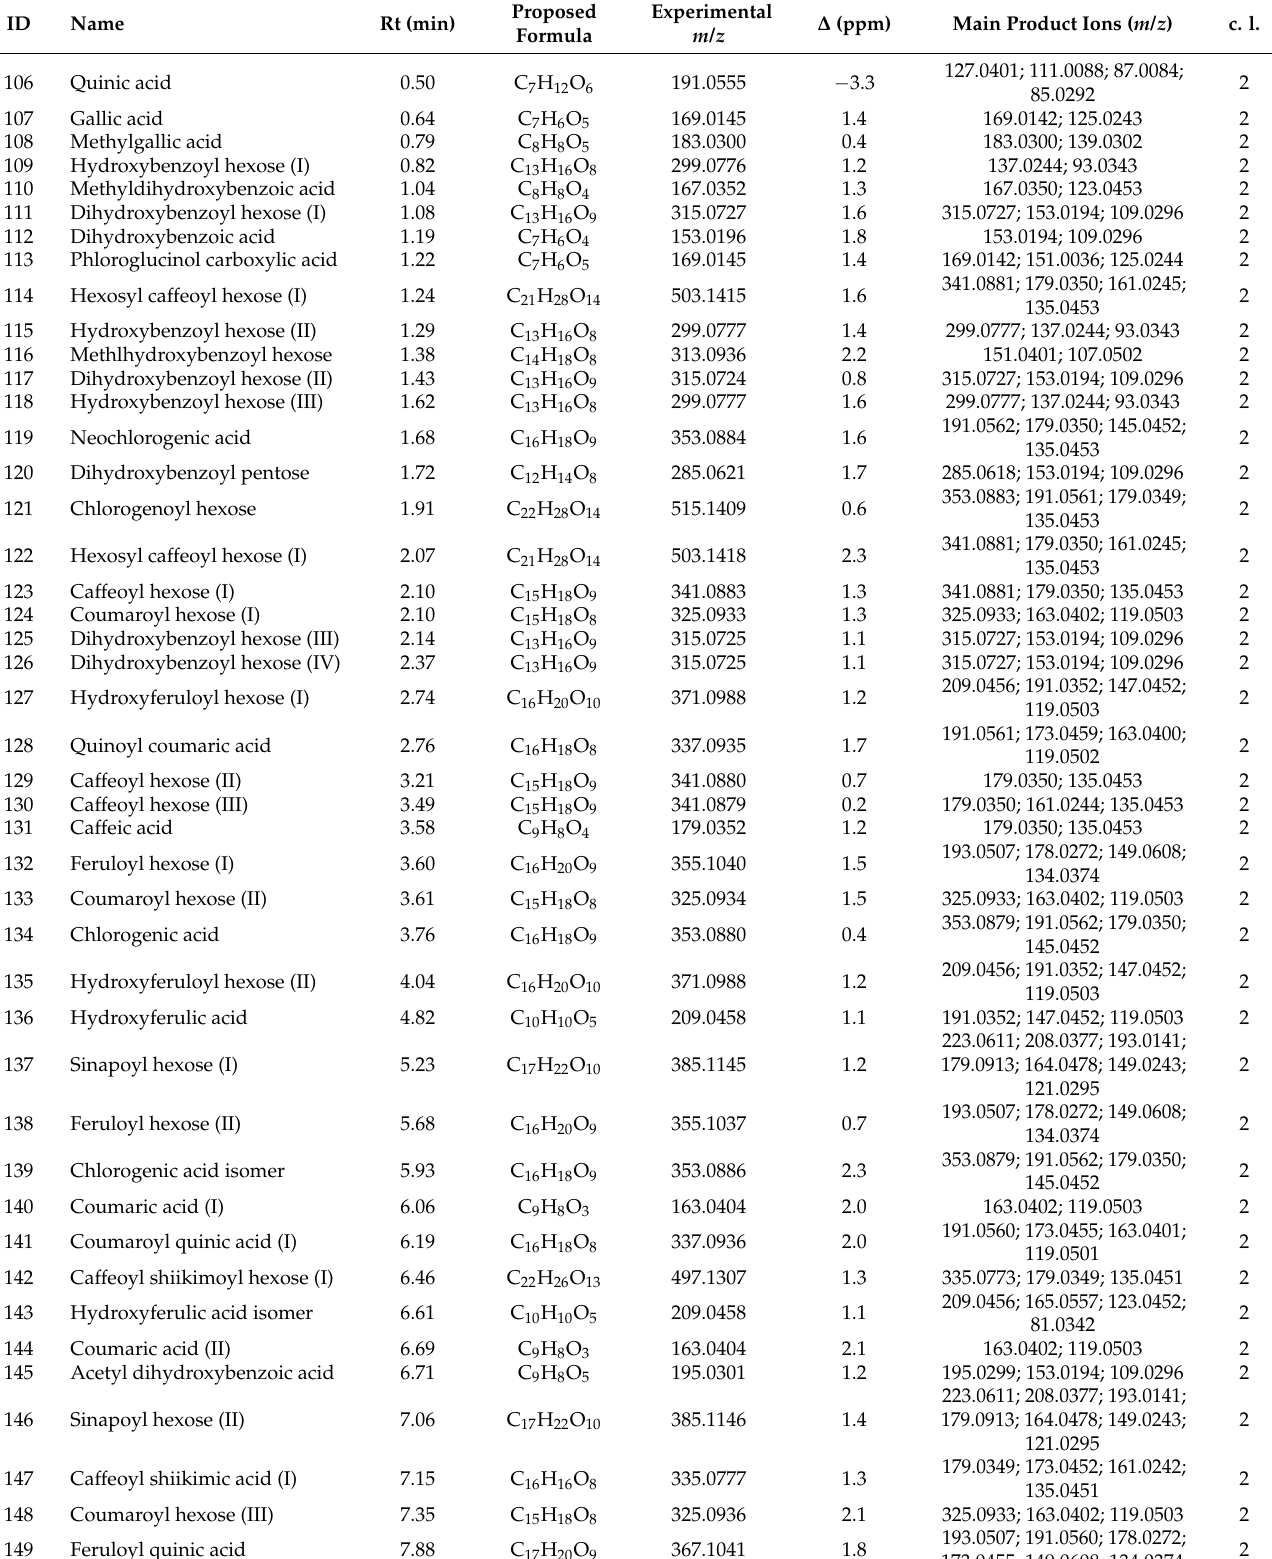
Table 3. Retention times (Rt, min), proposed formulas, experimental m/z , accuracy ( ∆ , ppm), main diagnostic experimental product ions, and confidence level of the identification (c. l.) of the 108 tentatively identified phenolic acid in Disterigma alaternoides extract in ESI( −